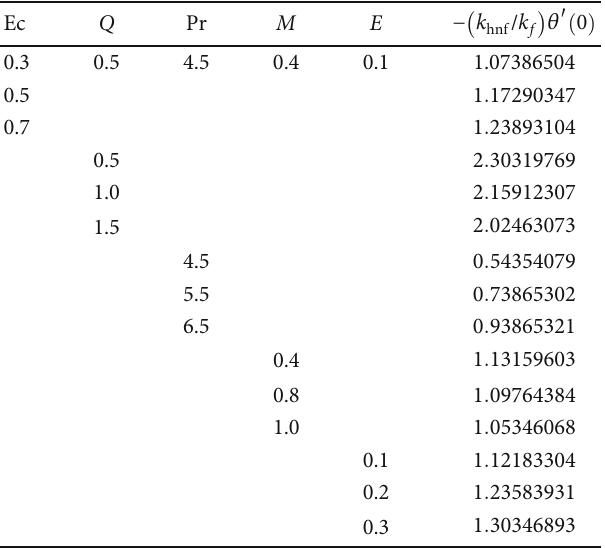
Table 4: Impact of di ff erent input factors on the Nusselt number ½ð − k / k f Þ θ ′ ð 0 Þ(cid:2) hnf